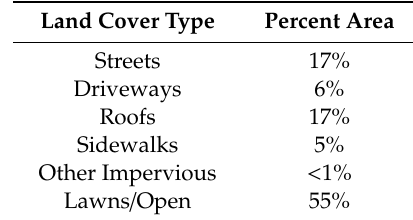
Figure 9. Yellowstone Drive catchment (WI) plan. Table 4. Percentage of area under each land cover. Table 4. Percentage of area under each land cover.